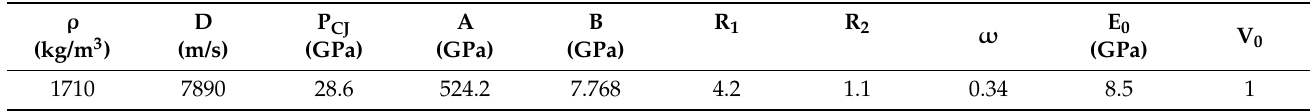
Table 3. MAT_HIGH_EXPLOSIVE_BURN material model and EOS_JWL parameters of the JH-2 [27].